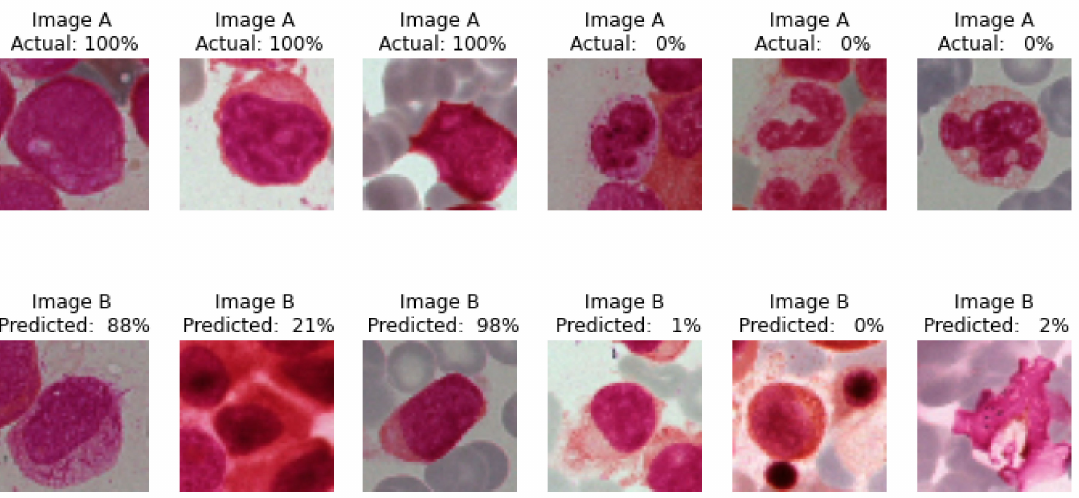
Figure 11. Confidence percentage of test images by Siamese model whether the input paired BM smear image belong to same class or